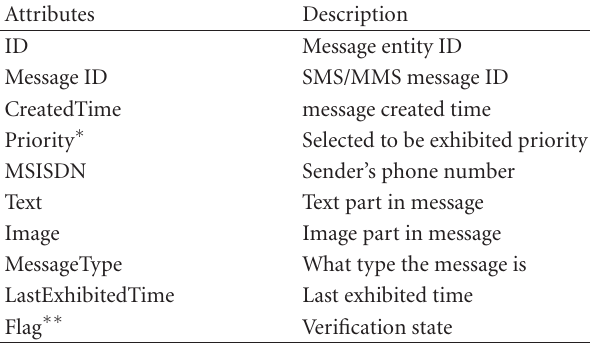
Table 1: Attributes of messages.